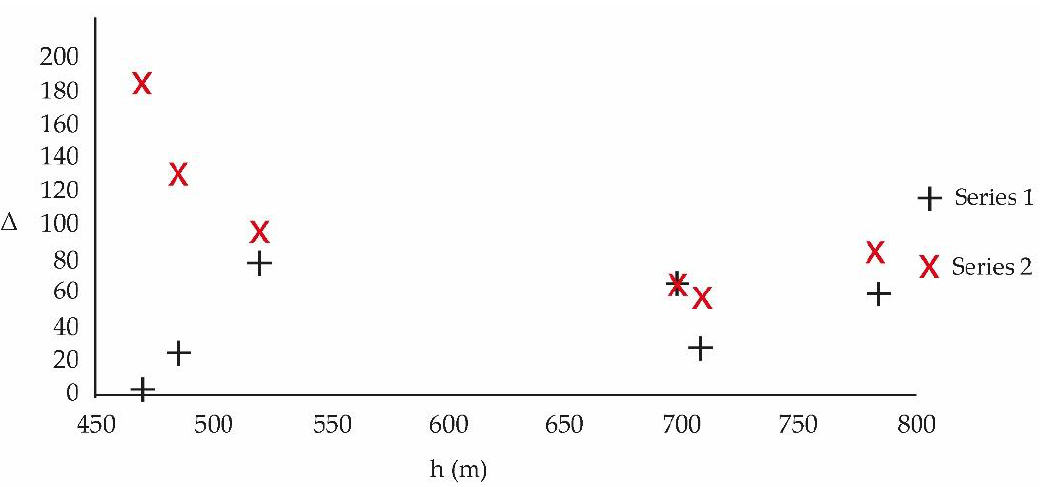
Figure 7 represents the difference ∆ between the heat variation in time of the pollutants and the heat variation in time of the meteorological variables according to the different measurement locations: